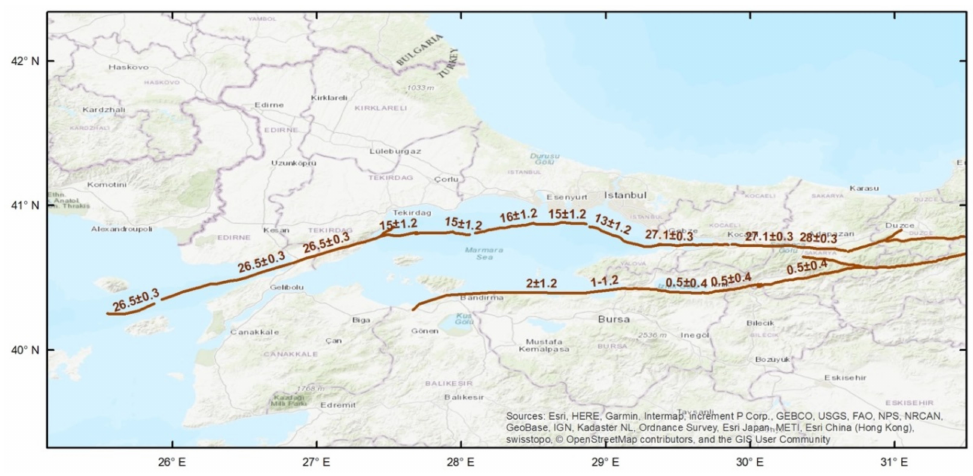
Figure 6. The active fault database compiled within the context of EU-FP7 Marsite project. Whenever available, the numbers on the fault segments indicate geodetic horizontal slip rates (in mm / year) as compiled by the